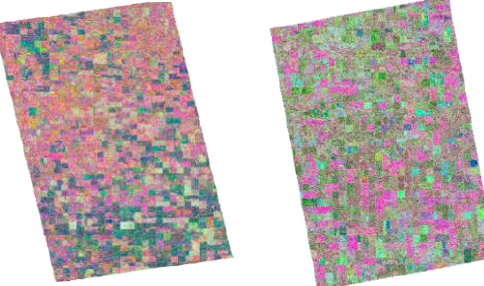
Figure 5 . H/A/ 𝛼 and Cloude decompositions